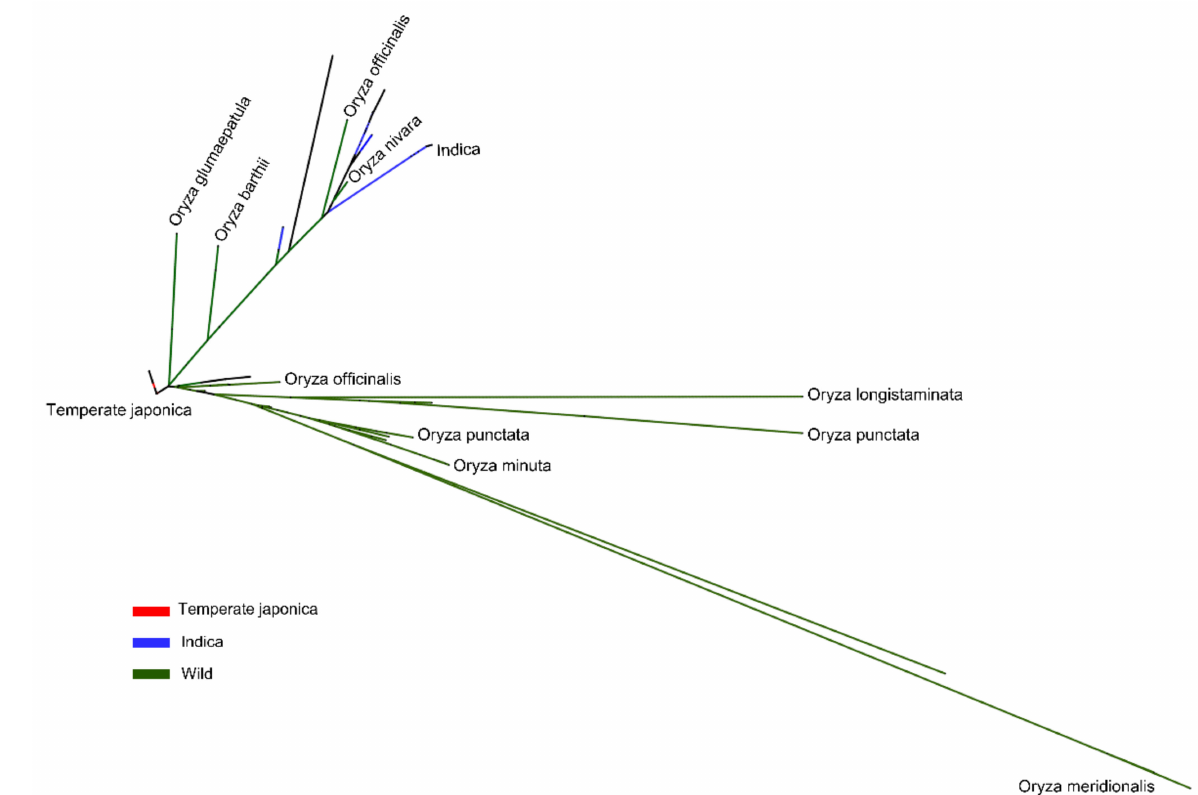
Figure 3. Phylogenetic tree of BADH1 gene in 475 rice accessions. The classified groups of cultivated rice were considered only in terms of major ecotypes, namely, Indica, Temperate Japonica, and Tropical Japonica, and their phylogenic relationship with wild rice. The tree was constructed for genetically different sequences of the BADH1 gene, using MEGAX software. The reliability of the neighbor-joining phylogeny output was estimated using bootstrap analysis with 1000